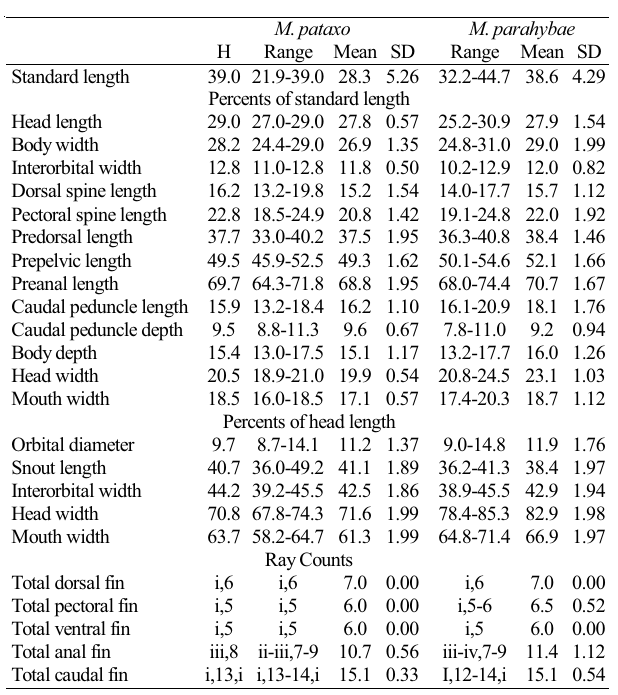
Fig. 3. Left lateral view of anal fin pterygiophores in M . pataxo (a) and M . parahybae (b). Abbreviations: ar, anal-fin rays; dr, distal radial; lp, laminar process; pr, proximal radials; rr, rudi- mentary ray; up, uncinate process. Scale bar, 1 mm. Table 1. Morphometric and meristic characters of the holo- type (H) and paratypes of Microglanis pataxo (n=25, includ- ing the holotype) and M . parahybae (n=12). SD = standard deviation.